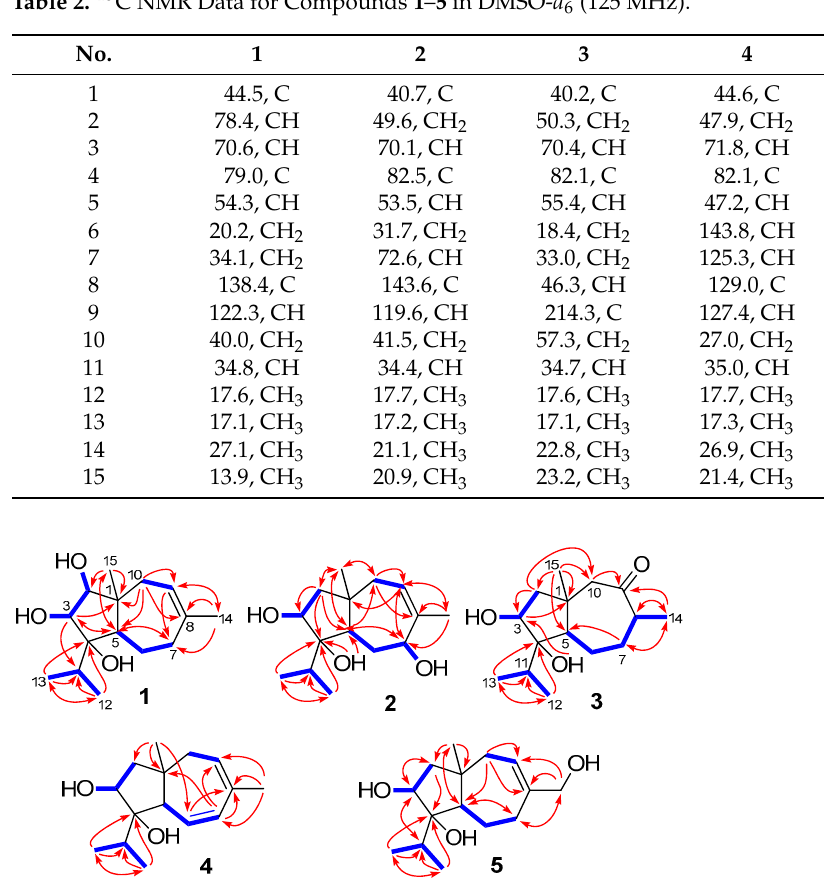
Figure 2. Key HMBC (arrows) and COSY (bold lines) correlations of compounds 1 − 5 . Table 1. 1 H NMR Data for Compounds 1 – 5 in DMSO- d 6 (500